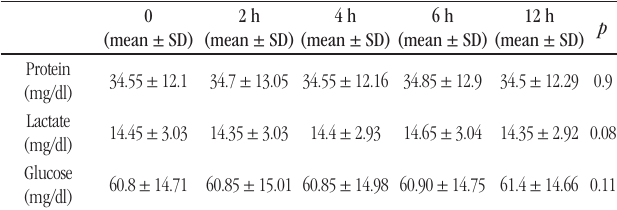
taBLE 3 − Mean protein, lactate, and glucose in the five different analyses times